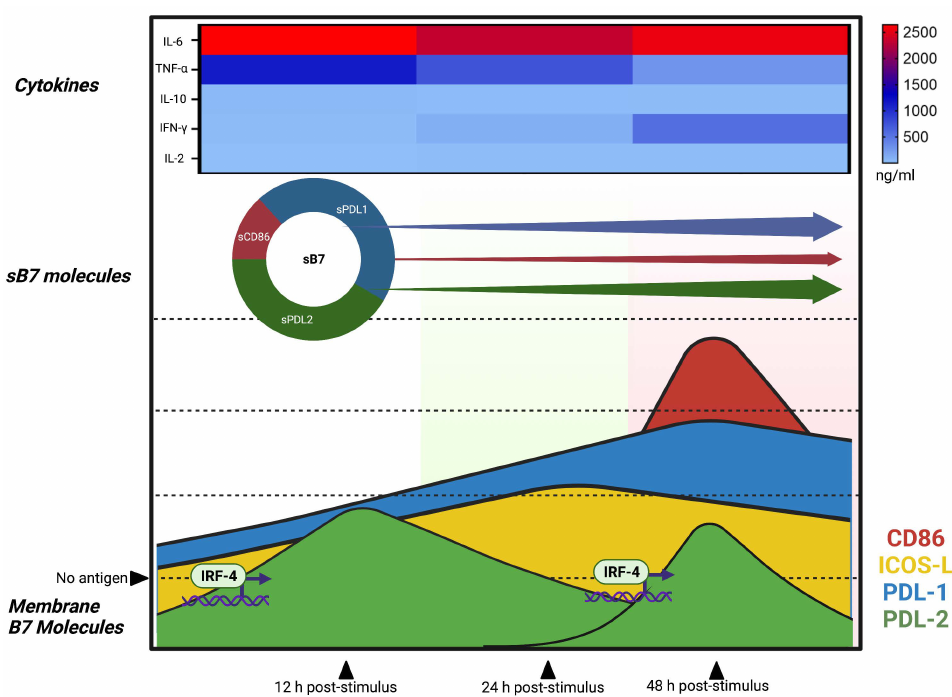
Figure 7. Integrative kinetic model explaining the behavior of B7 costimulatory molecules. Cos- timulatory molecules express in a differential fashion. Dendritic cells tend to increase PDL1 and ICOS-L expression during the early stages of antigen exposition. Additionally, transcription factor IRF4 expression promotes PDL2. After 24 h of stimulation, the expression of PDL1 is maintained. At 48 h, peak expression of molecules CD86 and PDL1 is observed. Regarding cytokines, TNF- α , IL-6, and IL-10 were found to increase at early stages; meanwhile, IFN- γ and IL-2 had a production peak at 48 h. Finally, soluble costimulatory molecules exhibited constant behavior regardless of the time of exposition or antigen concentration. sPDL1 and sPDL2 had twice the concentration of sCD86. Figure